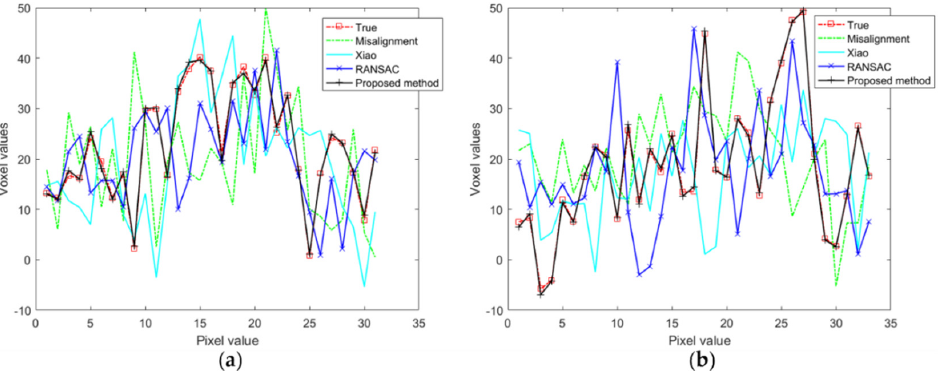
Figure 7. Comparison results of voxel values in red line position in Figure 6. ( a ) The pixel value corresponding to the (I) position in Figure 6. ( b ) The pixel value corresponding to the (II) position in Figure 6.